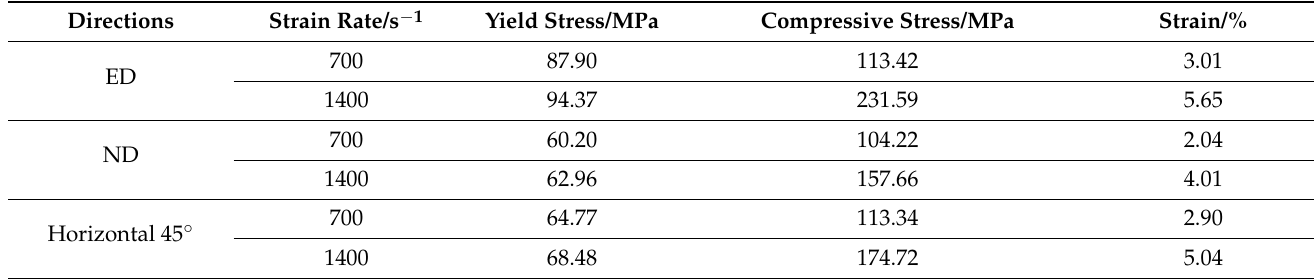
Table 2. Mechanical properties of Mg-Al-Ca-Mn alloy under high strain rate compression in different directions.